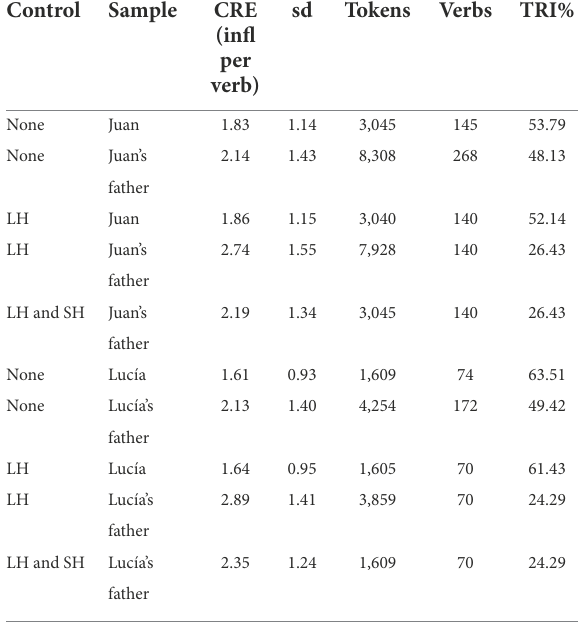
TABLE 3 Descriptive results for the productivity observed in the speech of Spanish speaking children and their respective caregivers.